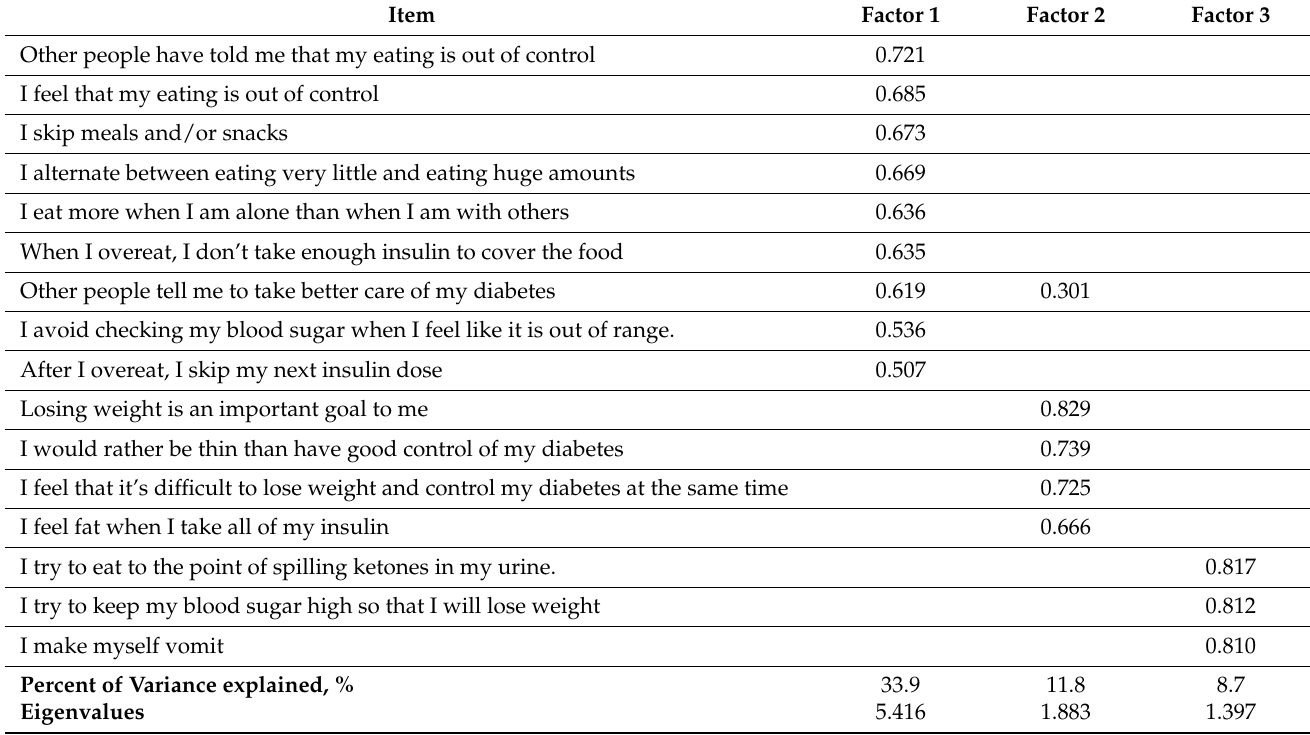
Table 3. Exploratory factor analysis with rotated component matrix